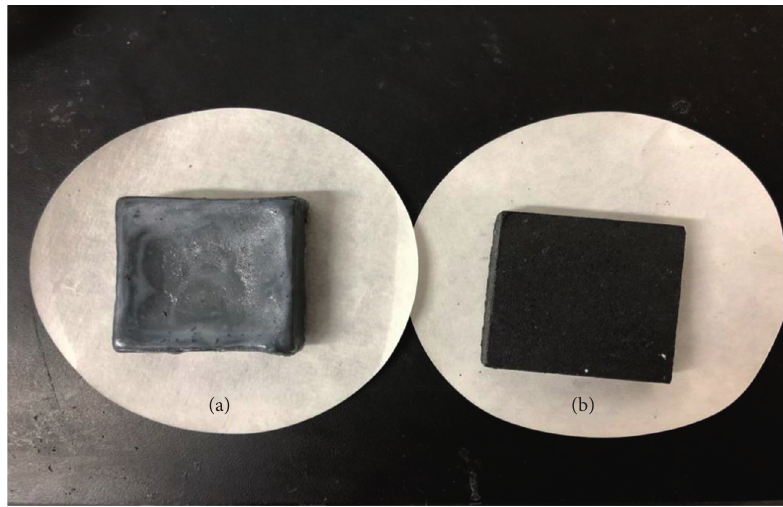
Figure 5: Sample leakage rates of the (a) PW/HDPE/CF and (b) PW/EG/CF/HDPE.